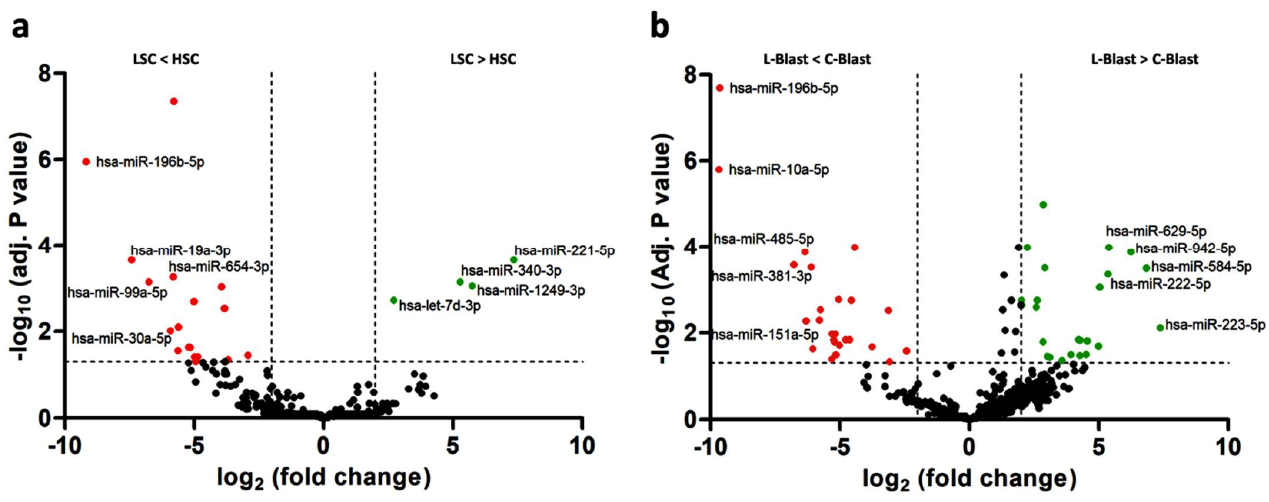
Figure 4. MiRNAs are plotted in volcano plots as log 2 FC values against − log10 adj. p values. ( a ) Volcano plot of miRNAs in LSCs compared to HSCs. ( b ) Volcano plot of miRNAs for L-blasts compared to C-blasts. Threshold |log2FC| > 2 and − log10 adj. p ≤ 0.05 are shown as dashed lines, significantly up- and downregulated miRNAs are highlighted in green and red, respectively. Top 5 up- and downregulated DE-miRNAs are indicated.